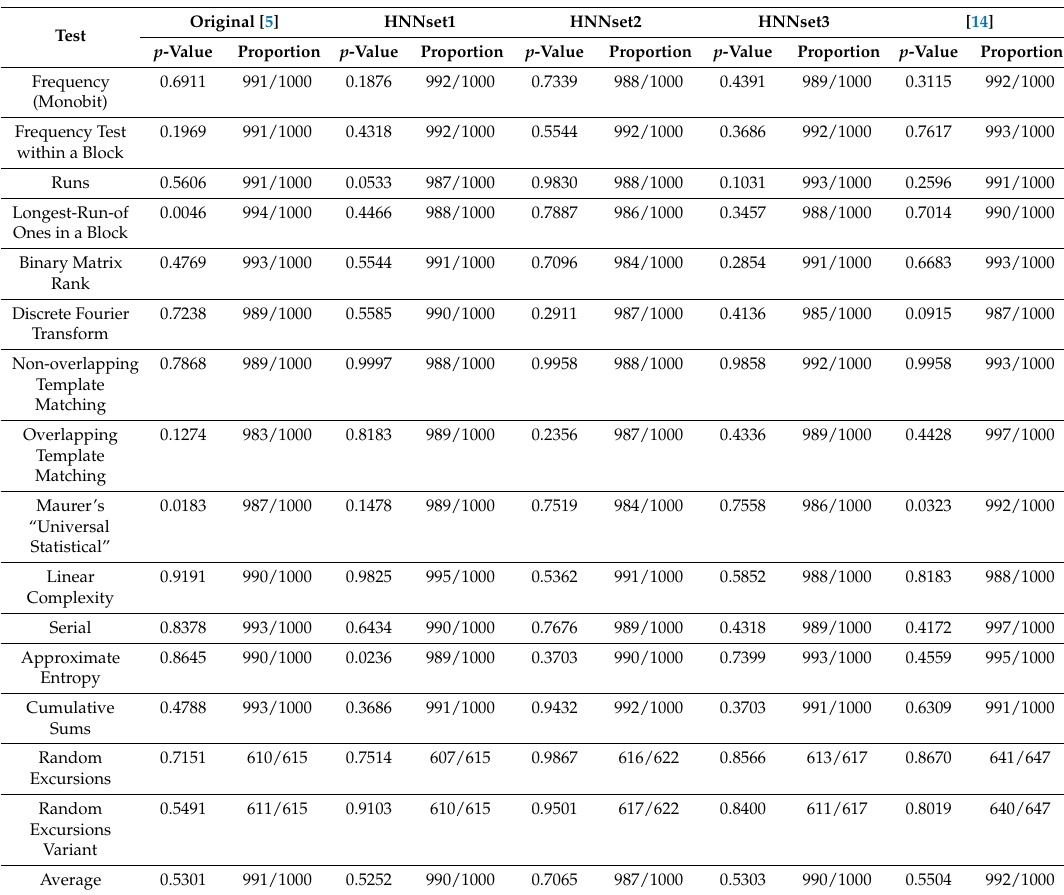
Table 8. National Institute of Standard and Technology (NIST) tests for the binary sequences generated by the Hopfield neural network for the state variable x , and for the sets of values given in Table 2.